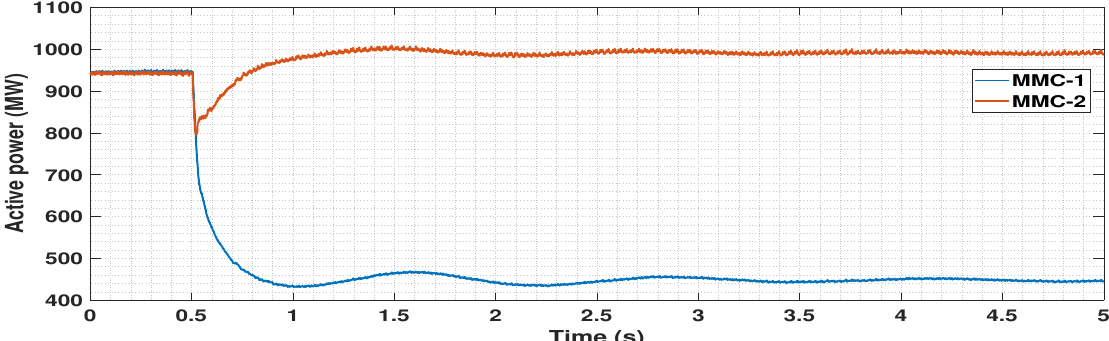
Figure 25. Active power in MMC-1 and MMC-2 buses upon OWF-2 disconnection event.